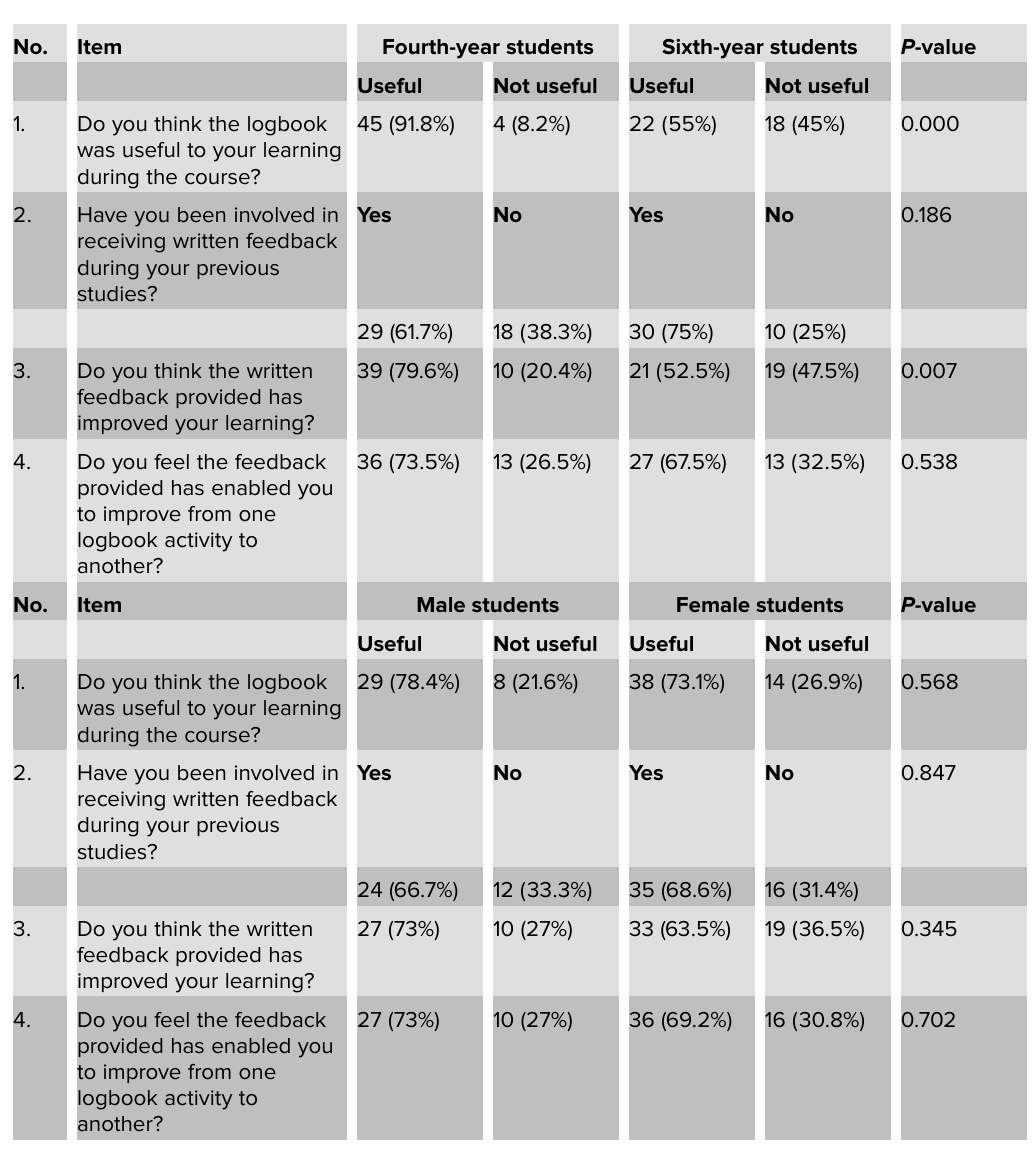
TABLE 3: Students’ responses to the closed-ended questions according to their level of study and gender ( N = 89; fourth year = 49, sixth year = 40, males = 37, females = 52).